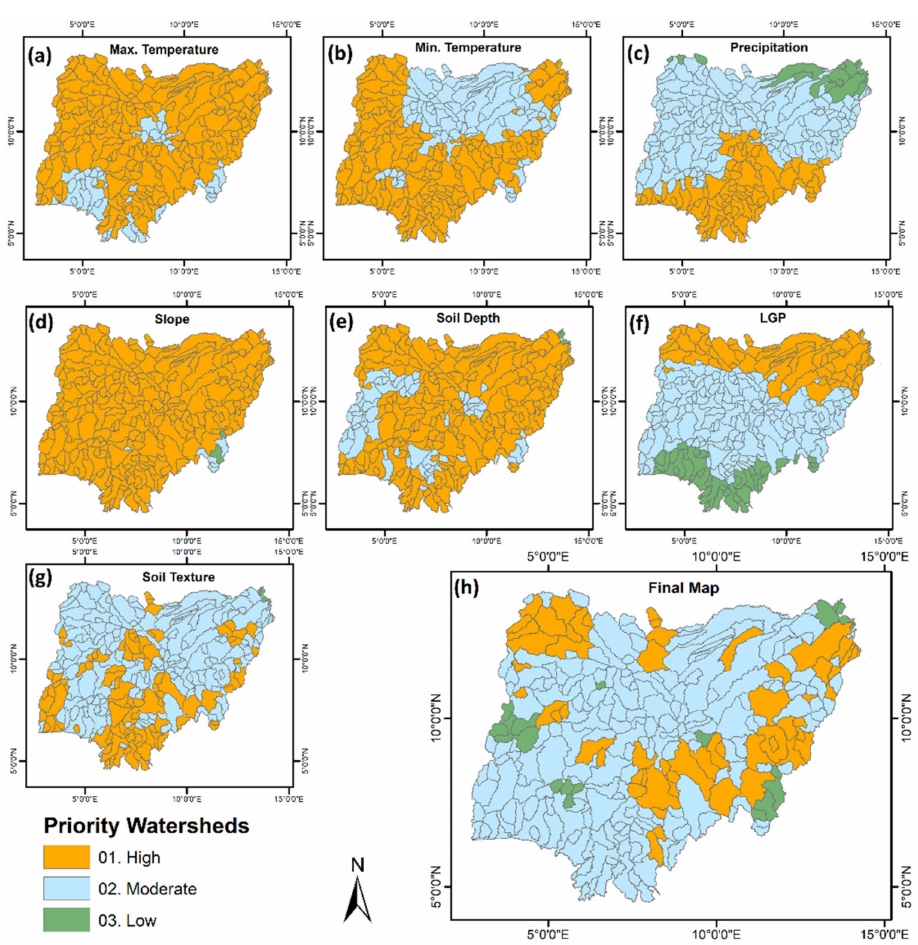
Figure 10. ( a – g ) Prioritized watershed maps as per thematic layer. ( h ) Prioritized watersheds after integration of all thematic layers in the study